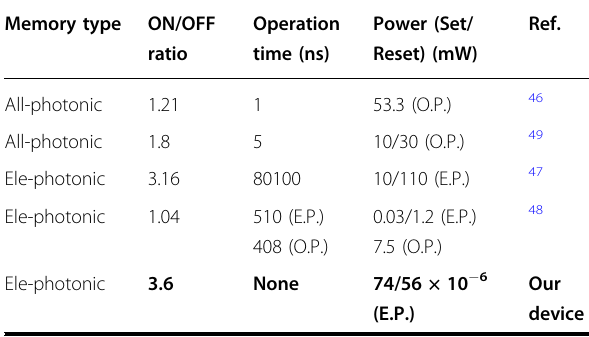
Table 1 Parameters of our device and peer works Memory